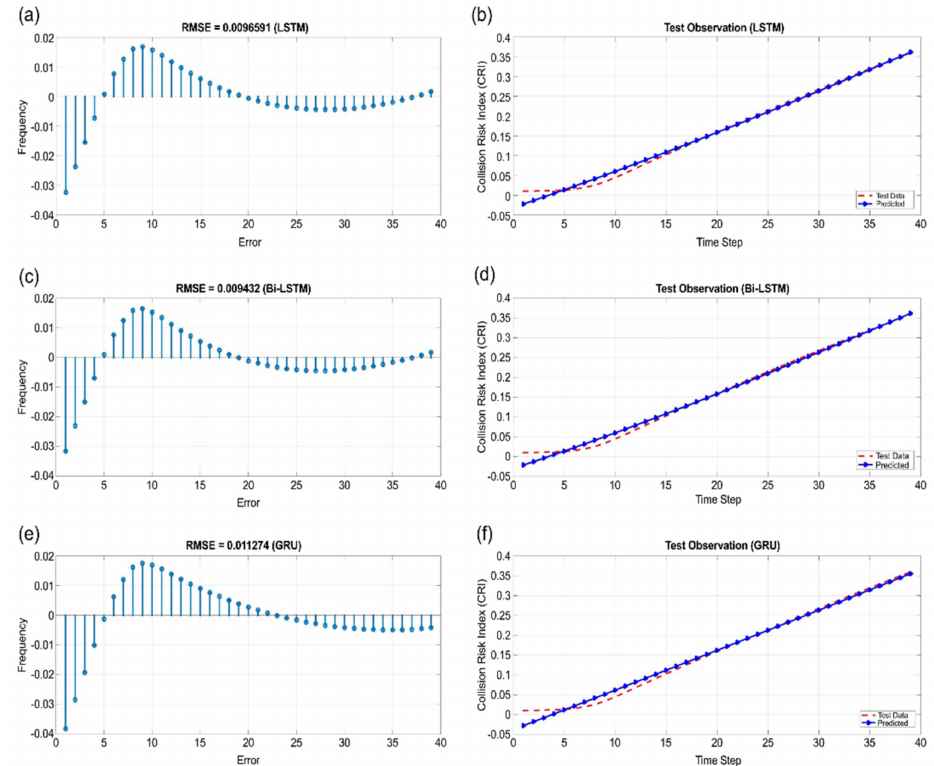
Figure 12. Sector V: ( a ) RMSE of LSTM, ( b ) test observation of LSTM, ( c ) RMSE of Bi-LSTM, ( d ) test observation of Bi-LSTM, ( e ) RMSE of GRU, and ( f ) test observation of